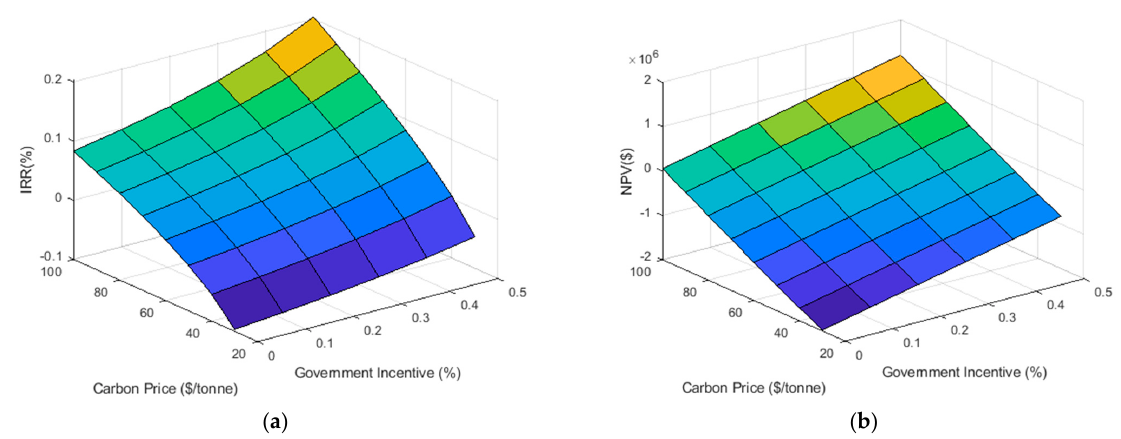
Figure 5. Surface plots illustrating the effect of changes in the carbon price and the government capital incentive on the annual Internal Rate of Return ( a ) and Net Present Value ( b ).